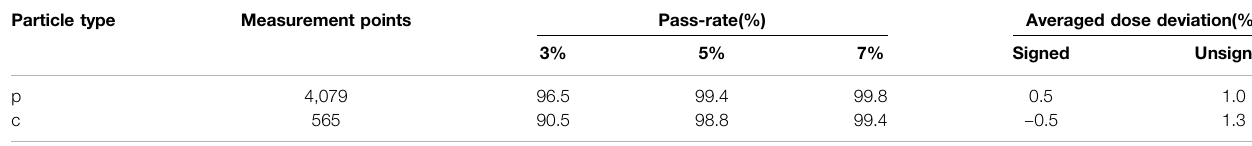
TABLE 3 | 3D validation overview for protons and carbon ions in terms of pass-rates (considering dose difference criteria of 3%, 5% and 7%) and average dose deviations. Particle type